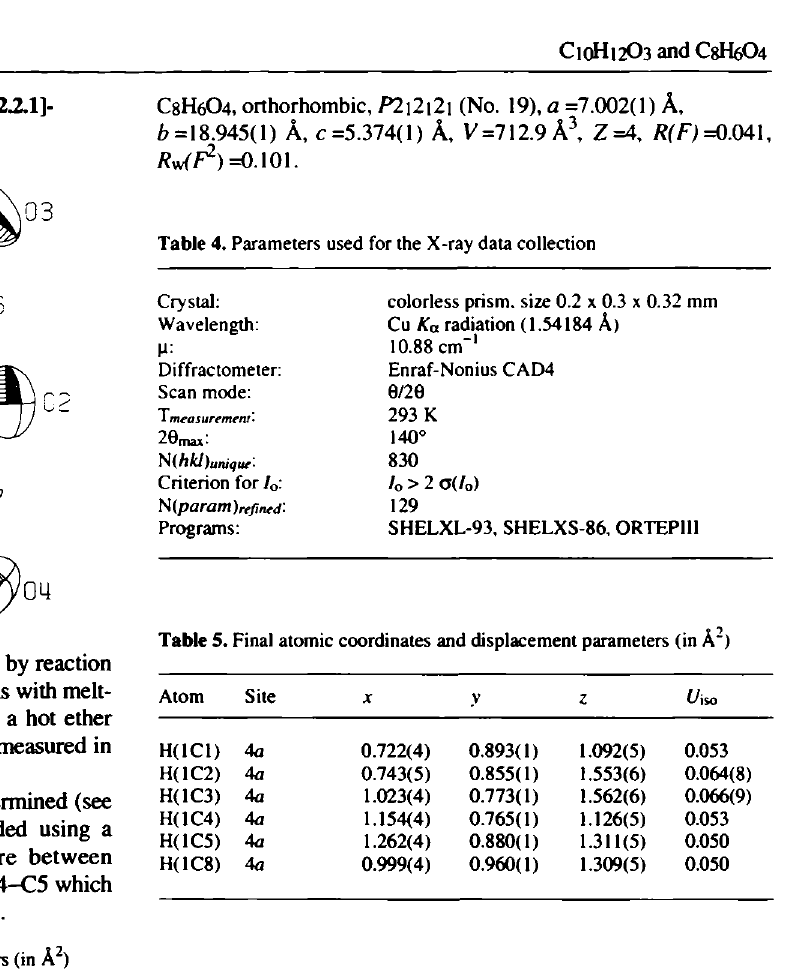
Table 6. Final atomic coordinates and displacement parameters (in Â^)